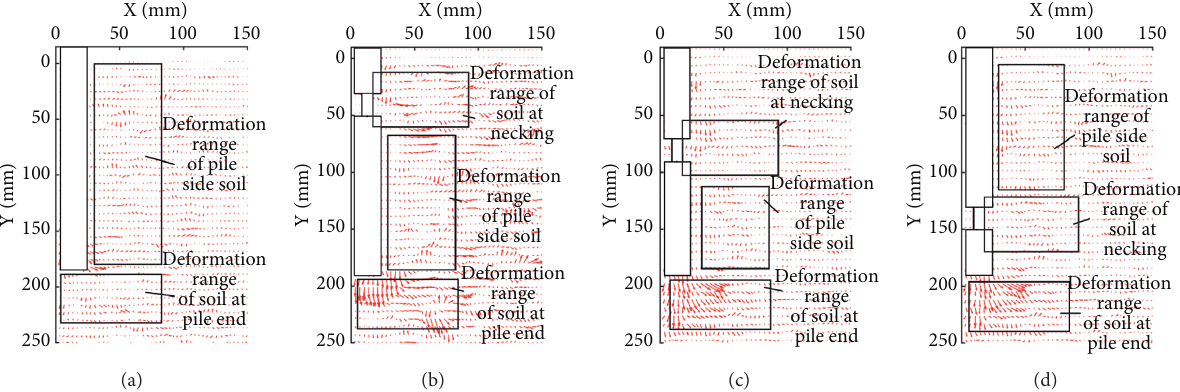
Figure 9: Displacement vector diagram of soil around the single pile under 220N load level. (a) Intact pile. (b) Necking in the shallow pile body. (c) Necking in the middle pile body. (d) Necking in the deep pile body.